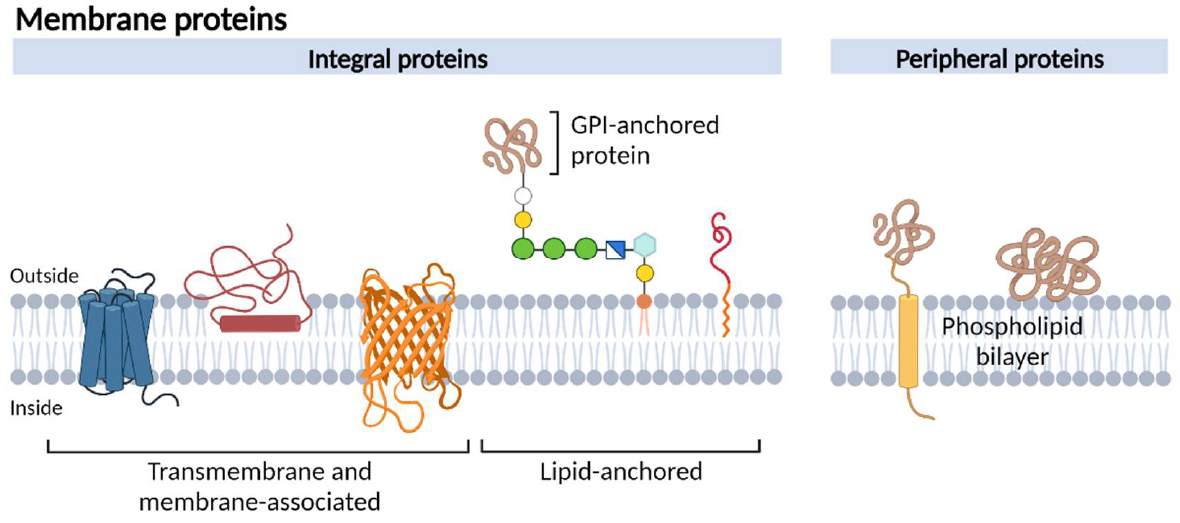
Figure 1. Schematic representation of different membrane protein types.